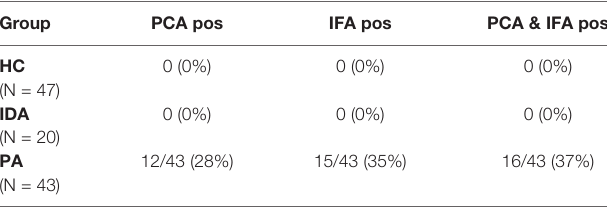
TABLE 2 | Laboratory features of PA patients, IDA patients and